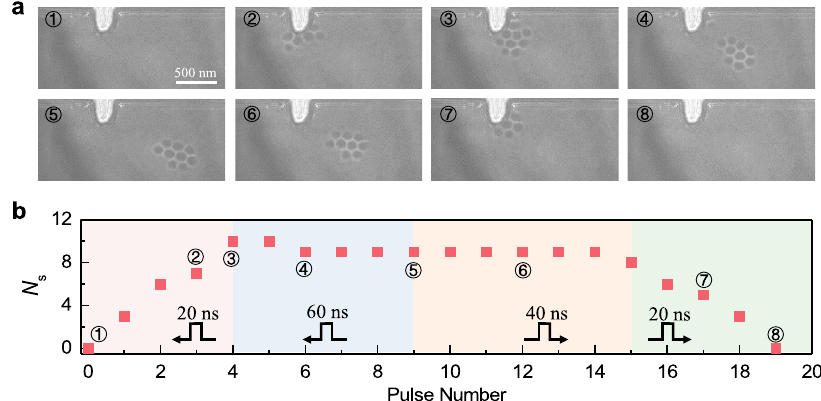
Fig. 5 Electrically manipulation of a skyrmion cluster: a combination of creation, motion, and deletion. a The snapshots of the skyrmion cluster on different stages. The skyrmion cluster is created in the fi rst stage ( ①②③ ) and moves forward in the second stage ( ③④⑤ ). Then, the skyrmion is pushed back in the third stage ( ⑥ ) and is fi nally deleted in the fourth stage ( ⑦⑧ ). b The details of the current pulses and the number of skyrmions as a function of pulse number are plotted. The current densities used on these four stages are (cid:1) 4 : 87 ´ 10 10 A (cid:3) m (cid:1) 2 , (cid:1) 2 : 03 ´ 10 10 A (cid:3) m (cid:1) 2 , 2 : 03 ´ 10 10 A (cid:3) m (cid:1) 2 and 3 : 65 ´ 10 10 A (cid:3) m (cid:1) 2 , single device shown in Fig. 4 (see the details in Supplementary Movie 8 and Supplementary Fig. S12 for other datasets). In the fi rst stage, a skyrmion cluster with ten skyrmions is created with the pulse width of 20 ns and j (cid:4) (cid:1) 4 : 86 ´ 10 10 A (cid:3) m (cid:1) 2 as shown in Fig. 4a. In the second stage, the skyrmion cluster is displaced by 680 nm after fi ve pulses with the pulse width of 60 ns and j (cid:4) (cid:1) 2 : 03 ´ 10 10 A (cid:3) m (cid:1) 2 . After that, the skyrmion cluster is pulled back with the pulse width of 60 ns at j (cid:4) 2 : 03 ´ 10 10 A (cid:3) m (cid:1) 2 . In the fi nal stage, the skyrmion cluster is deleted eventually with the pulse width of 20 ns at j = 3 : 65 ´ 10 10 A (cid:3) m (cid:1) 2 .